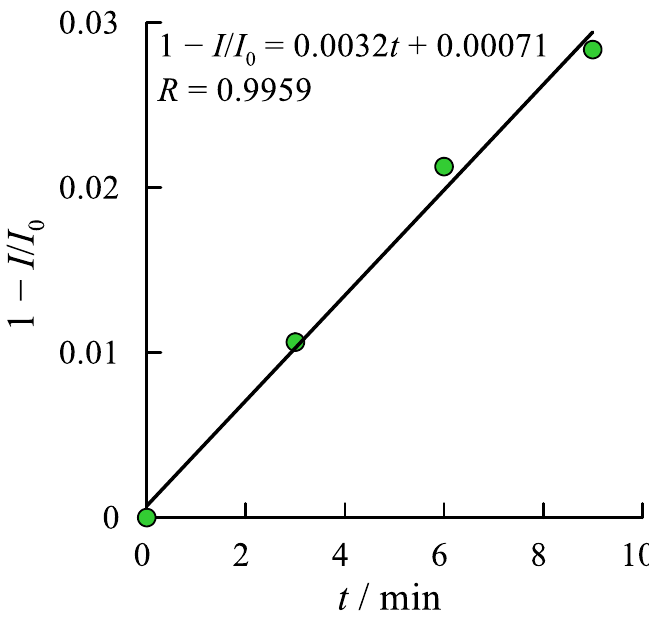
Figure 4. Dependence of the relative change of the ER O 2 current against time of the interaction between ROS and antioxidant at the glassy carbon electrode modified by cobalt phthalocyanine in phosphate buffer (2.5 × 10 –2 M, pH = 7.3) for the blood serum of patient treated with Cytoflavin. All the curves represent straight lines in the range of relatively low antioxidant concentrations. The slope angle tangent of these lines is suggested to be a coefficient of the antioxidant activity K given by Equation (5).